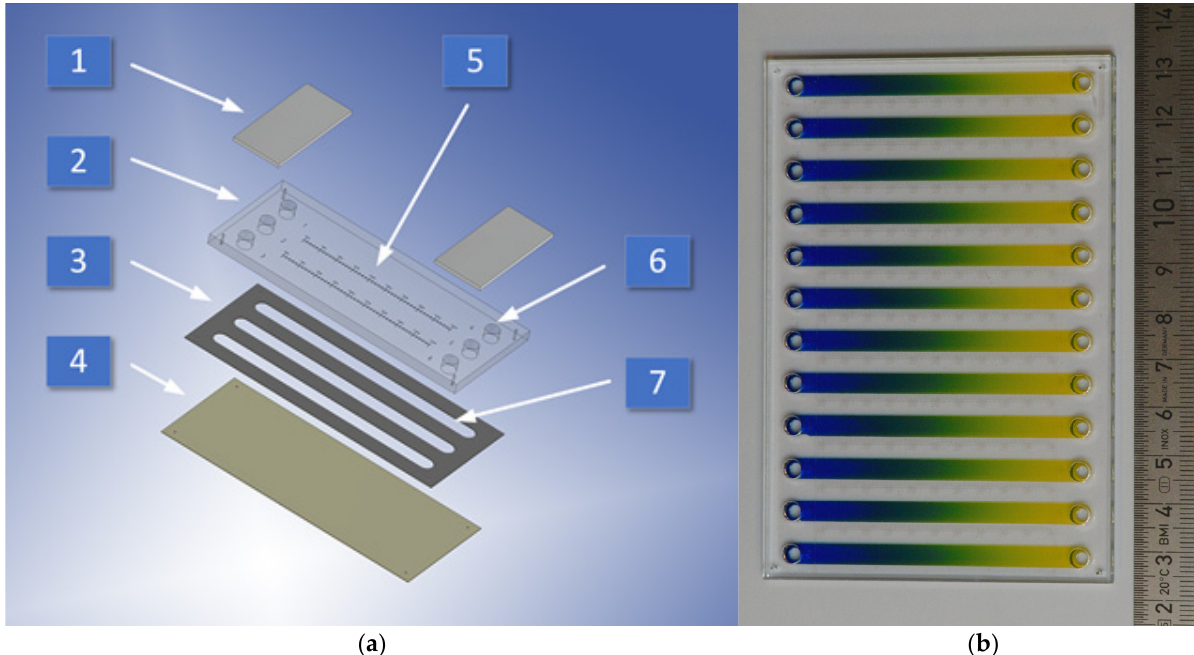
Figure 2. A microfluidic device for the high-throughput screening assay, ( a ) three-chamber configuration, ( b ) twelve-chamber configuration with developed counter-current molecular gradient of two dyes. 1—reservoirs cover, 2—top layer (lid), 3—middle layer (adhesive film), 4—bottom layer (base), 5—graduated scale, 6—fluid reservoirs, 7—culture chambers CC.